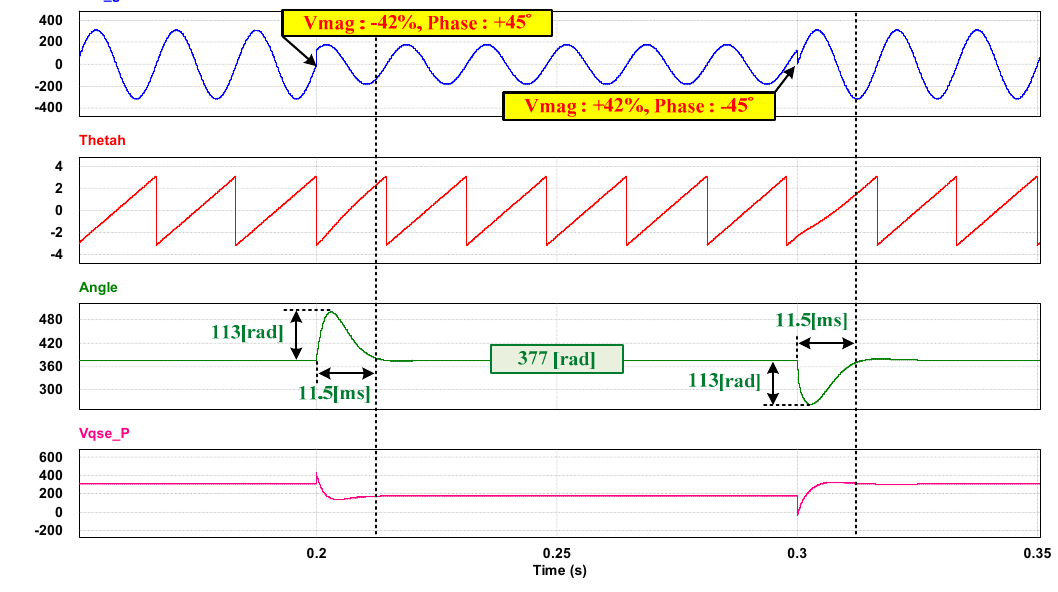
Figure 14. Single-phase SRF-PLL simulation results.